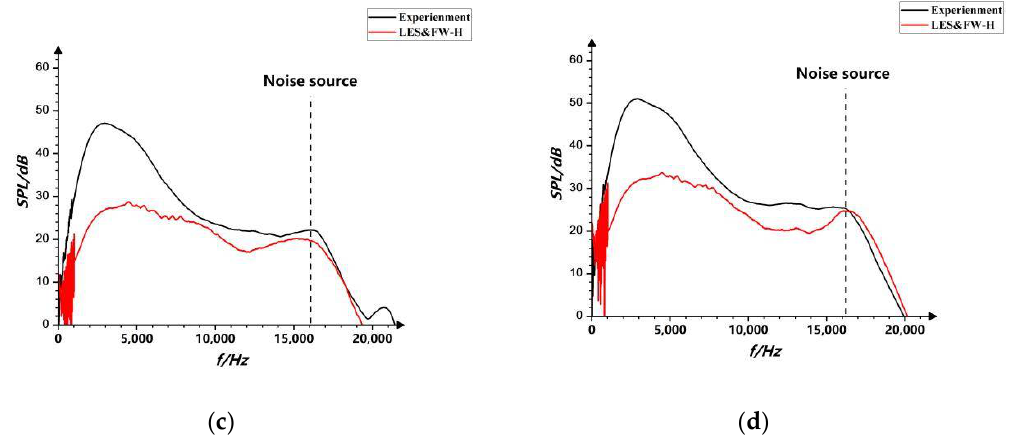
Figure 17. The wind angle 45°. ( a ) Wind speed 25 m/s; ( b ) Wind speed 30 m/s; ( c ) Wind speed 35 m/s; ( d ) Wind speed 40 m/s.